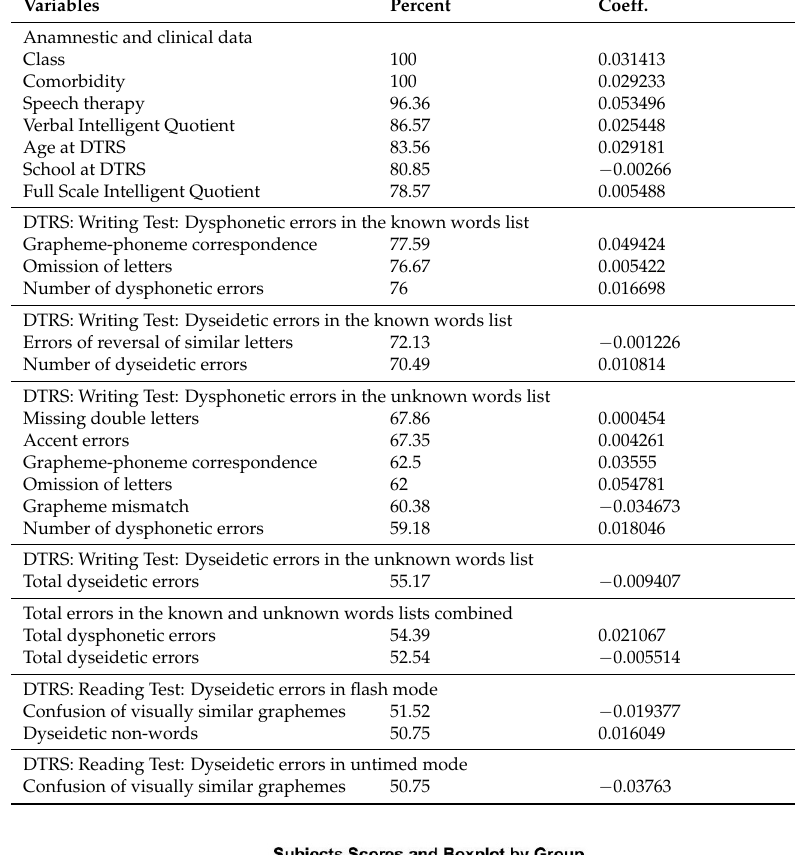
Table 6. Biomarkers obtained from the classification procedure with the Clinical and Anamnestic variables (first column). The second column indicates the percent of the times the variables were selected as biomarkers during the random classification procedure. The third column is the coefficient that accompany each variable in the final classification equation. The stable area under the ROC for this equation is 0.94.